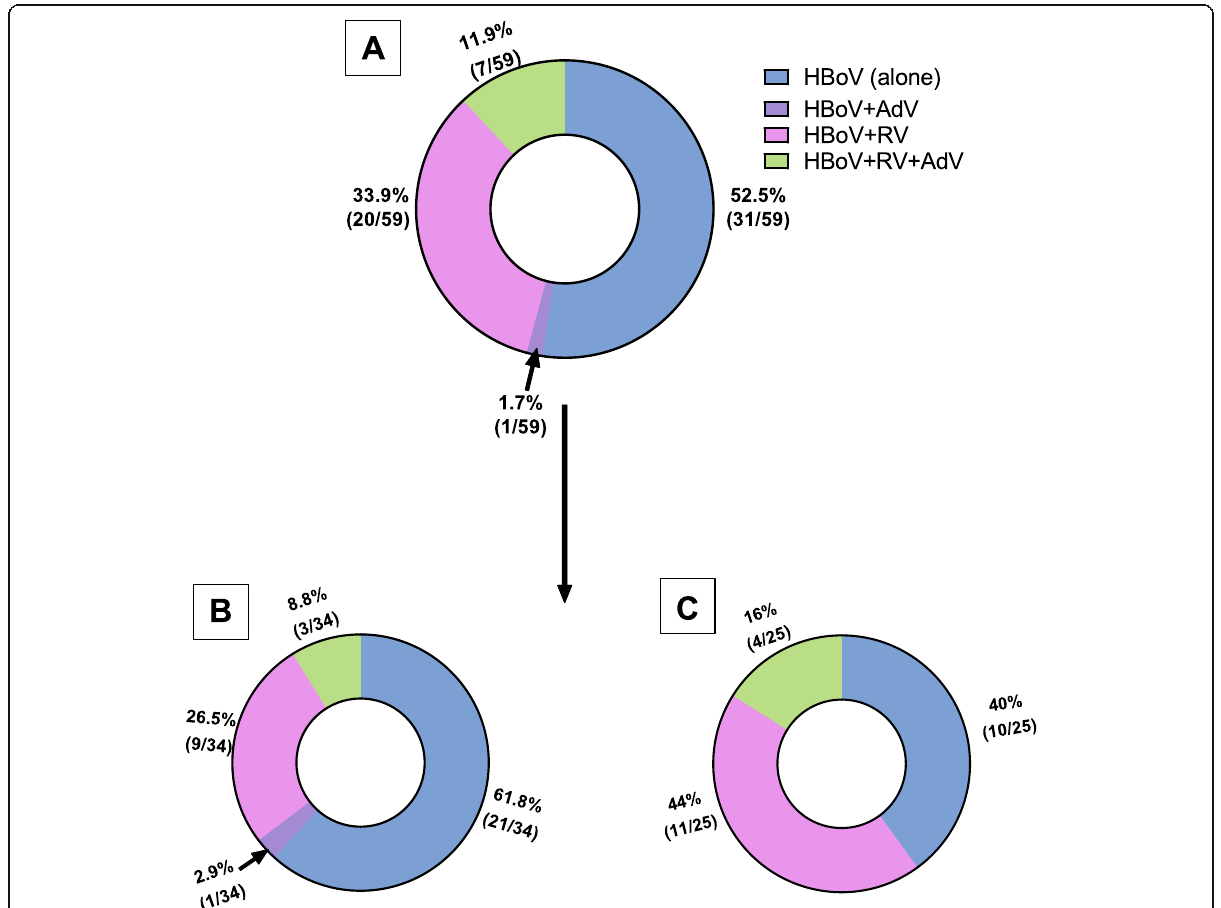
Fig. 2 Different infection types in HBoV-positive samples. A Total positive samples for HBoV ( n = 59). B Males positive samples. C females positive